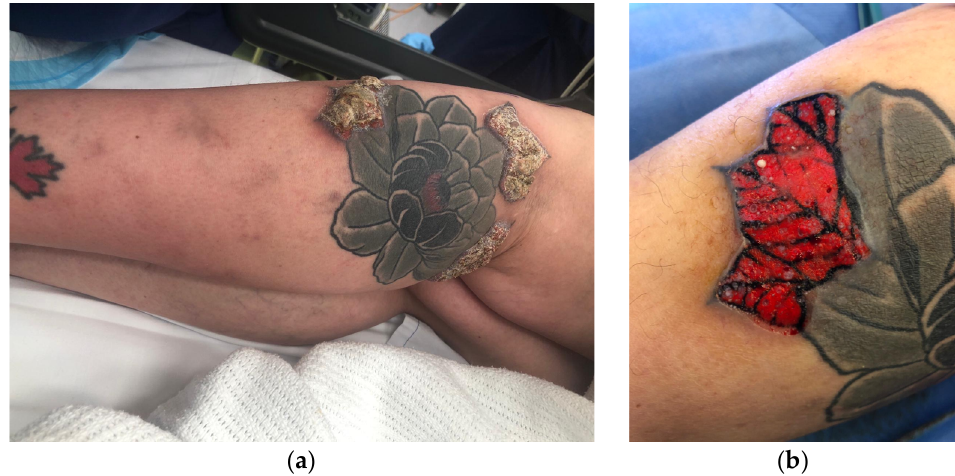
Figure 4. Skin lesion affecting exclusively red-ink tattooed areas 6 months after initial tattoo was completed ( a ). Macroscopic appearance after deep shave biopsy was performed ( b ).